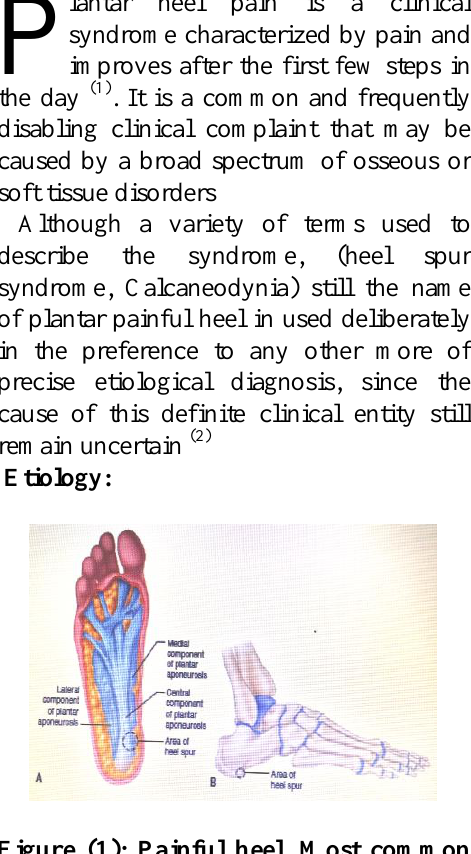
Figure (1): Painful heel. Most common location heel pain.